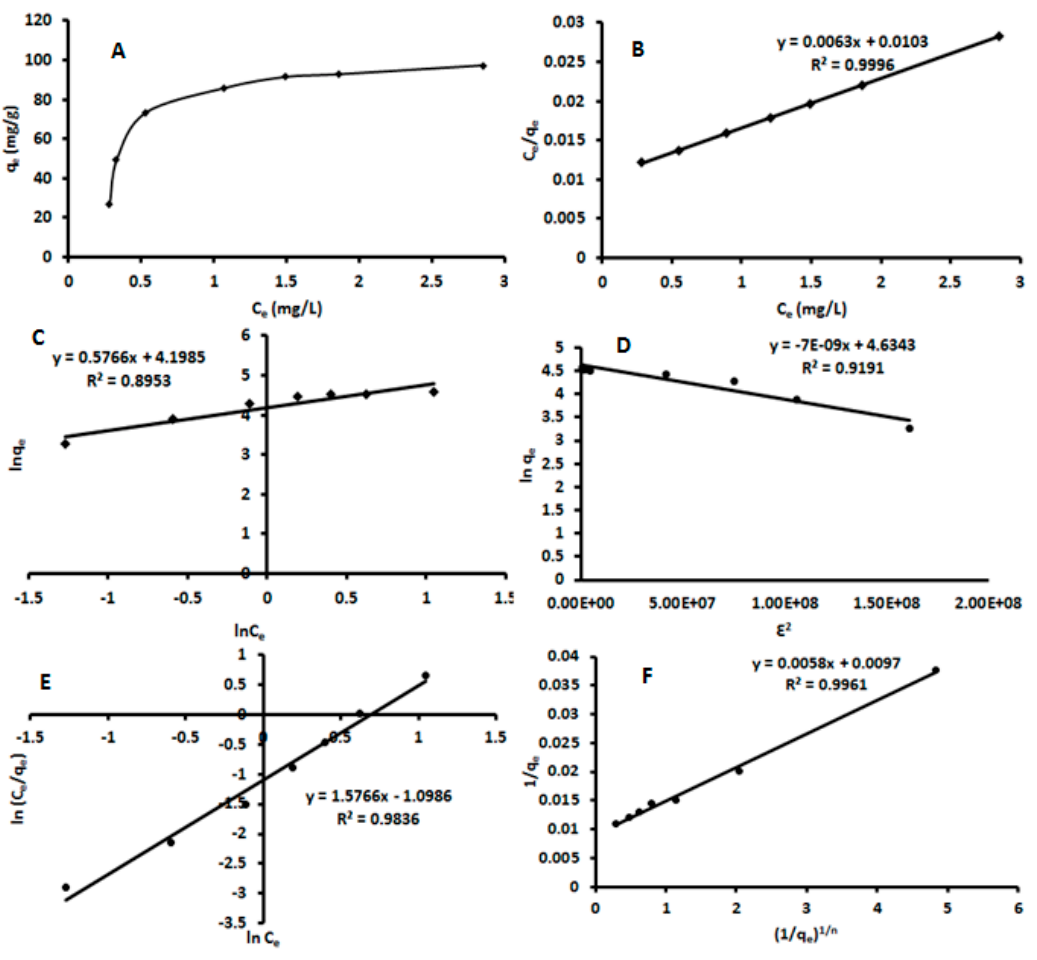
Figure 5. Adsorption isotherm plots for the sorption of β -estradiol using akaganeite ( A )—Langmuir isotherm model; ( B )—Langmuir linear model; ( C )—Freundlich linear model; ( D )—Dubinin–Radushkevich linear model; ( E )—Redlich–Peterson linear model; ( F )—Sips linear model.